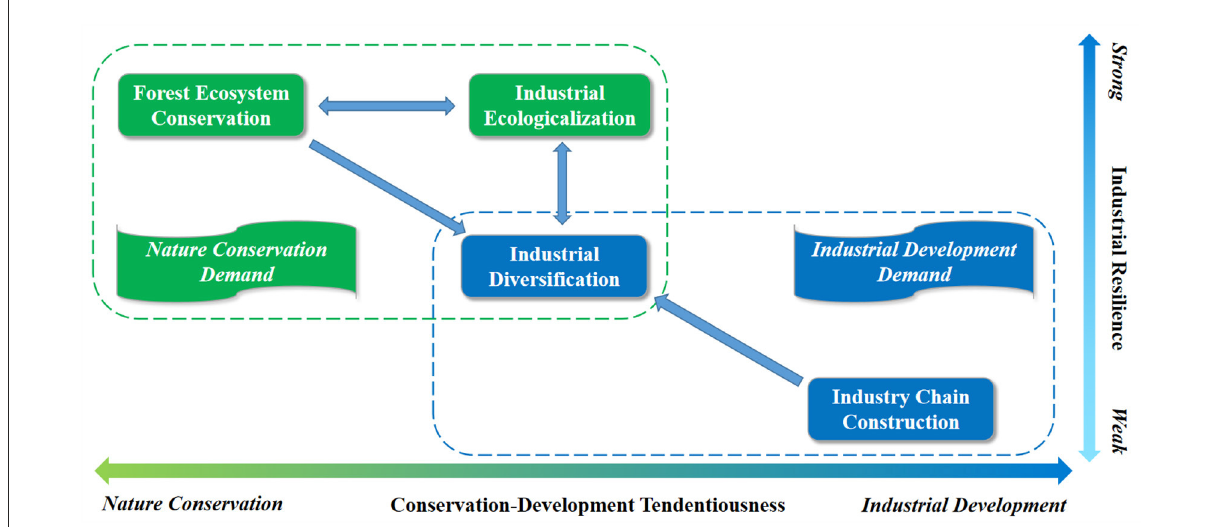
FIGURE4 Synergistic mechanism of management objectives and industrial transformation. Note: Green represents ecologicalization and blue represents industrialization. The colorful flag represents conservation or development demand. The colorful rounded rectangle represents the direction of ecologicalization and industrialization. The orange hexagon represents the objective of industrial transformation. The solid blue line represents a strong correlation and the blue dashed line represents a weak correlation. The solid gray line represents the correlation between demand and industrial transformation. The spectrum change of the horizontal axis from green to blue represents the trade-off tendentiousness of conservation and development. The spectrum change of the vertical axis from light blue to dark blue represents the enhancement of industrial